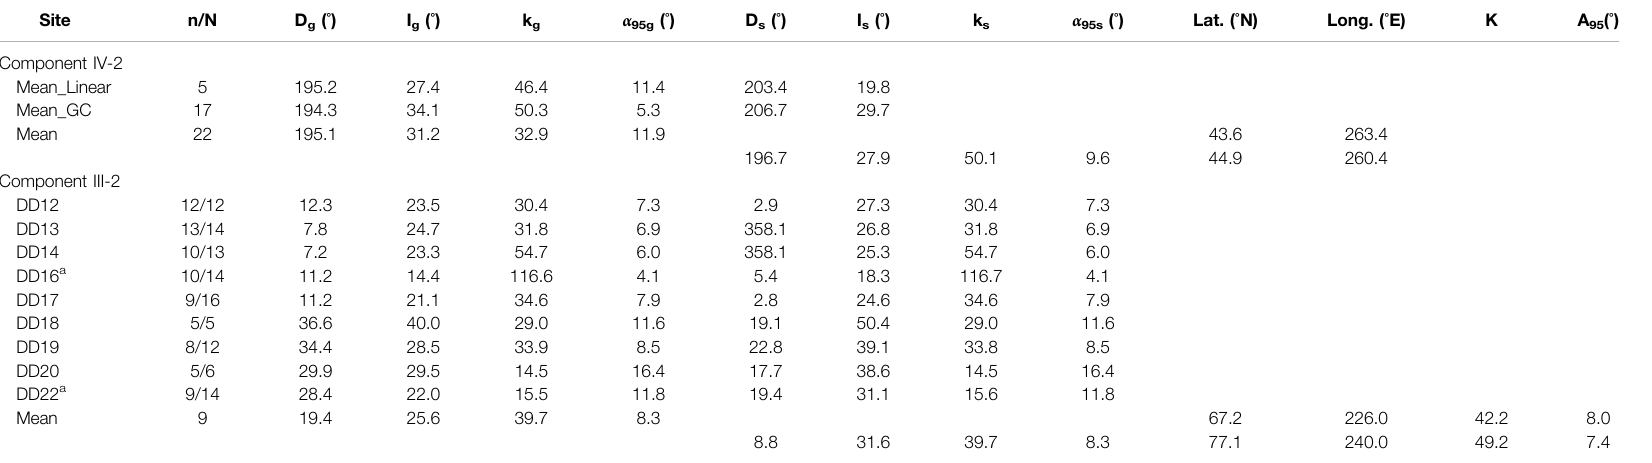
TABLE 3 | Paleomagnetic directions and statistics of ChRM (IV-2 and III-2) from sites DD7-22 at the Dadi section. Site Component IV-2